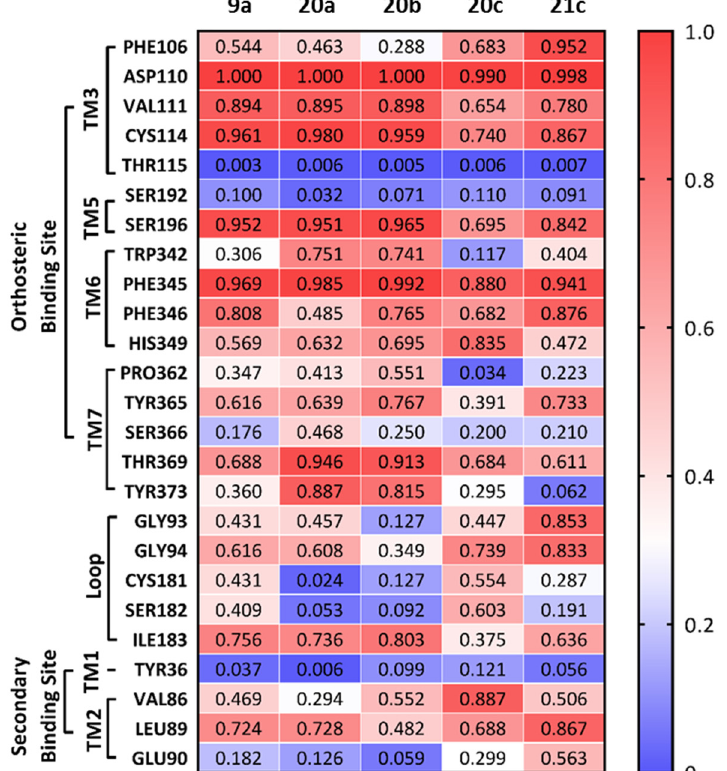
Figure 1. Representative poses of MDS for ( a ) 9a , ( b ) 21c , ( c ) 20a , ( d ) 20b , and ( e ) 20c . The predicted interactions of each compound with residues in the OBS and the SBS of the D 3 receptor were distin- guished by the color. Red: hydrogen; cyan: π -interactions; green: halogen bond.